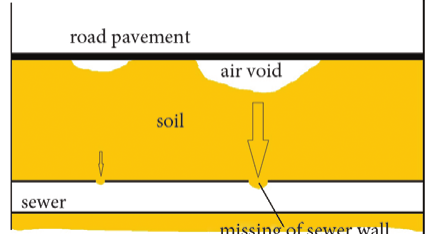
Fig. 9. Air voids above a leaky sewer in a non-cohesive soil